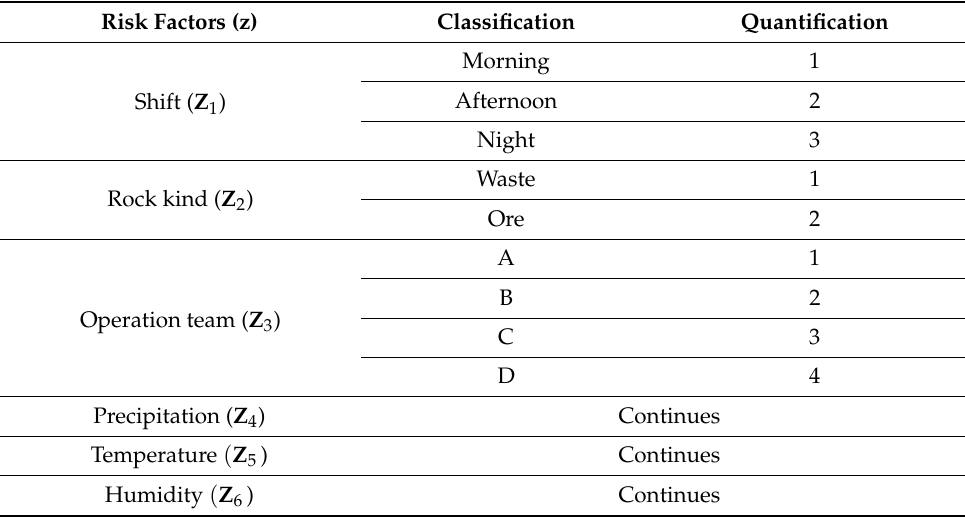
Table 1. The classification and quantification of qualitative risk